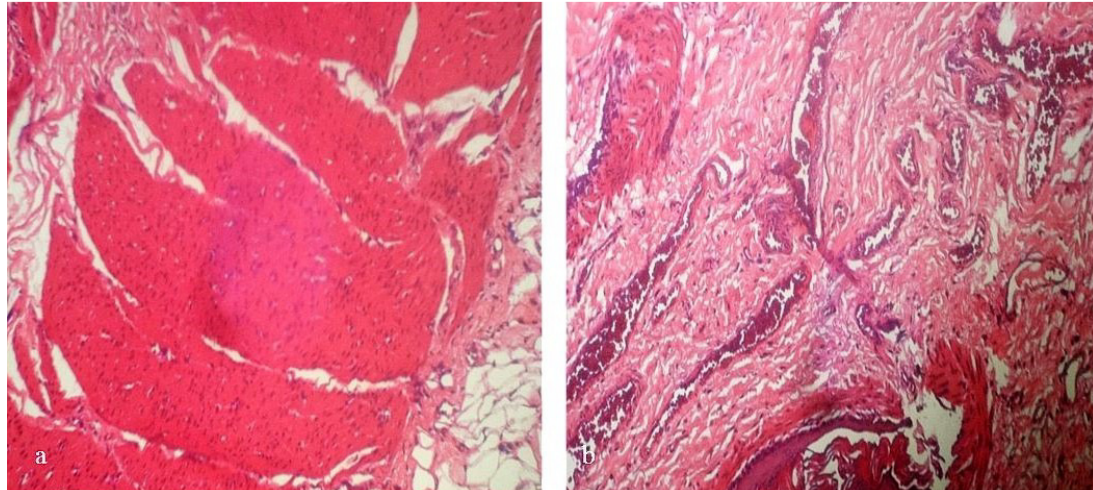
Fig. 5. Induced and treated with 60 mg kg -1 cimetidine: Photomicrograph shows G.I.T. section with marked muscle hyperplasia supported by adipocytes; a) Mag. X 200 and numerous dilated blood vessels; b) Mag. X